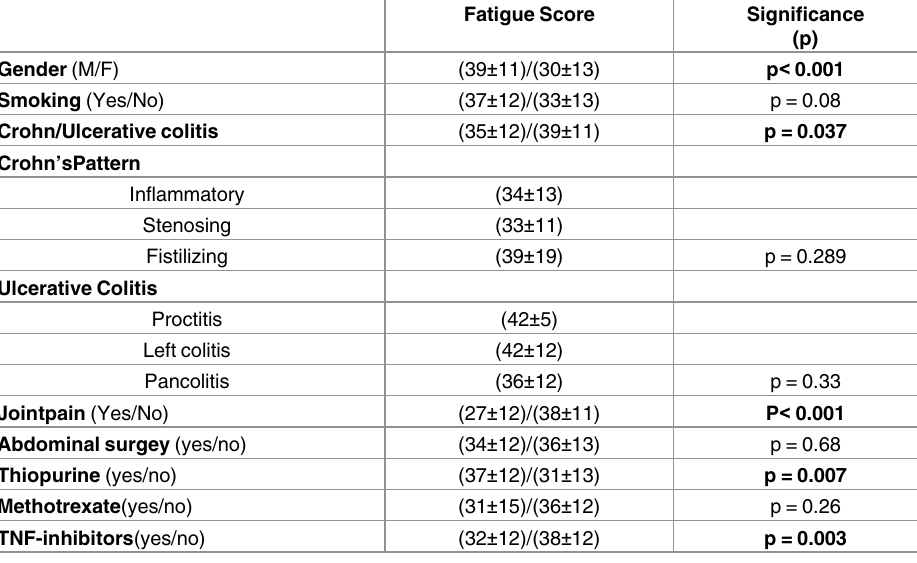
Table 2. Relationship between fatigue and biological variables: Univariate analysis. Fatigue Score Significance (p) Gender (M/F) (39 ± 11)/(30 ± 13) p < 0.001 Smoking (Yes/No) (37 ± 12)/(33 ± 13) p = 0.08 Crohn/Ulcerative colitis (35 ± 12)/(39 ± 11) p = 0.037 Crohn’sPattern Inflammatory (34 ± 13) Stenosing (33 ± 11) Fistilizing (39 ± 19) p = 0.289 Ulcerative Colitis Proctitis (42 ± 5) Left colitis (42 ± 12) Pancolitis (36 ± 12) p = 0.33 Jointpain (Yes/No) (27 ± 12)/(38 ± 11) P < 0.001 Abdominal surgey (yes/no) (34 ± 12)/(36 ± 13) p = 0.68 Thiopurine (yes/no) (37 ± 12)/(31 ± 13) p = 0.007 Methotrexate (yes/no) (31 ± 15)/(36 ± 12) p = 0.26 TNF-inhibitors (yes/no) (32 ± 12)/(38 ± 12) p = 0.003 Data are expressed in mean ± standard